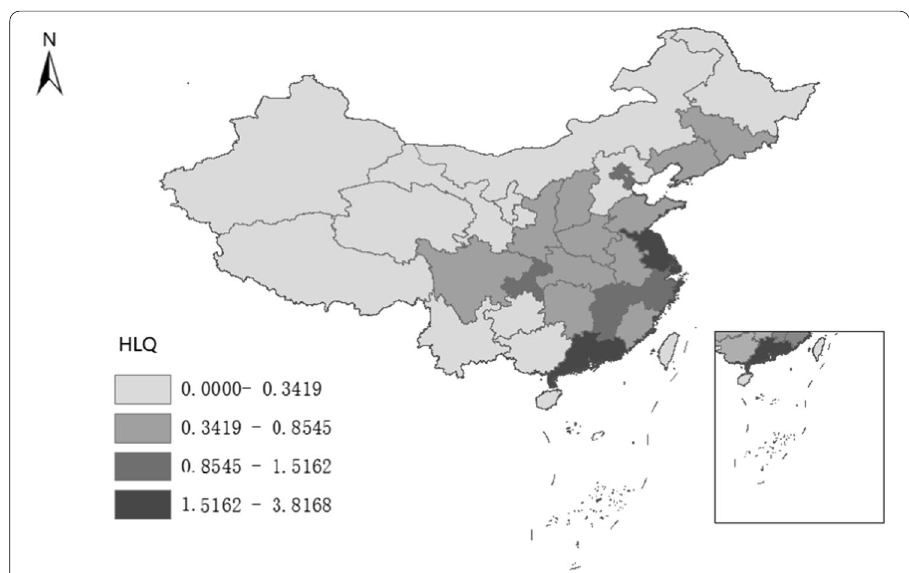
Fig. 3 The spatial pattern of high-tech industry agglomeration in